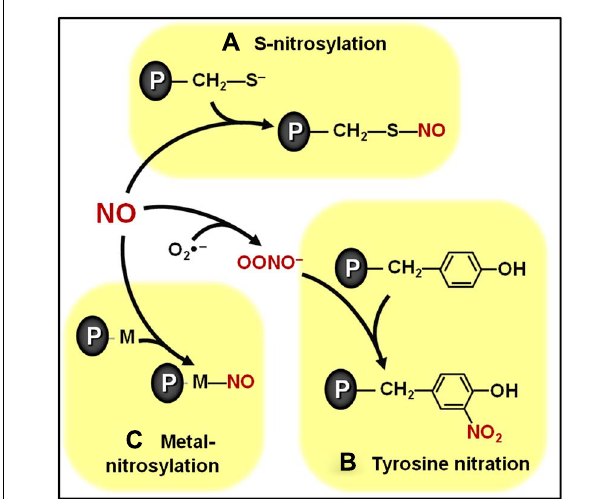
FIGURE 1 | Overview of biologically relevant NO-dependent post- translational modifications (PTMs). (A) S -nitrosylation of cysteine residues. (B) Tyrosine nitration. (C) Metal nitrosylation. Proteins are represented with gray ovals and “P”